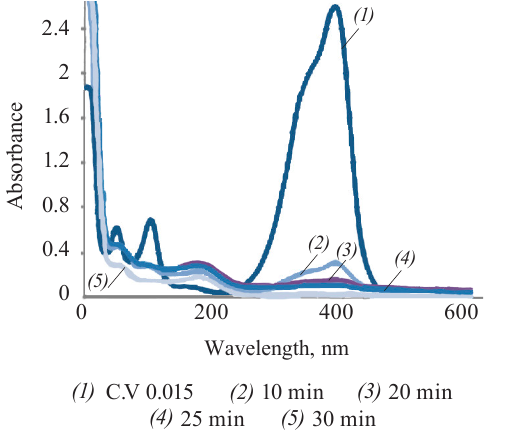
Figure 4 Absorbance of methyl orange at different contact time